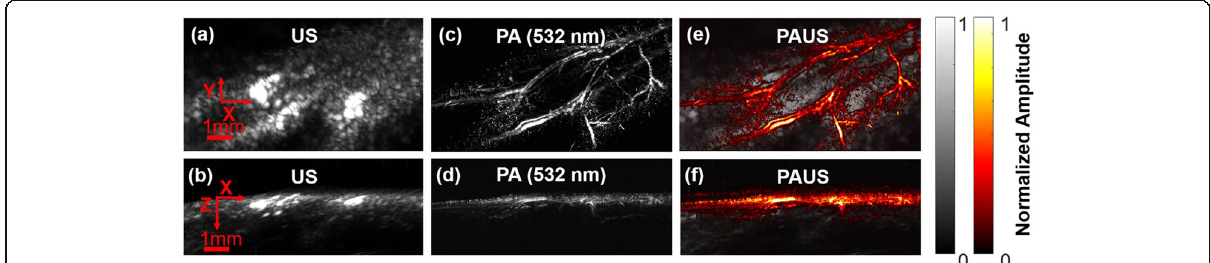
Fig. 5 Dual-transducer PAUS of mouse hind paw. In vivo PAUS results with two single-element focused ultrasonic transducers, showing the XY and XZ projections for US ( a , b ), PA ( c , d ), and fused PAUS ( e , f ). The FOV in the XY plane was 9 × 5 mm